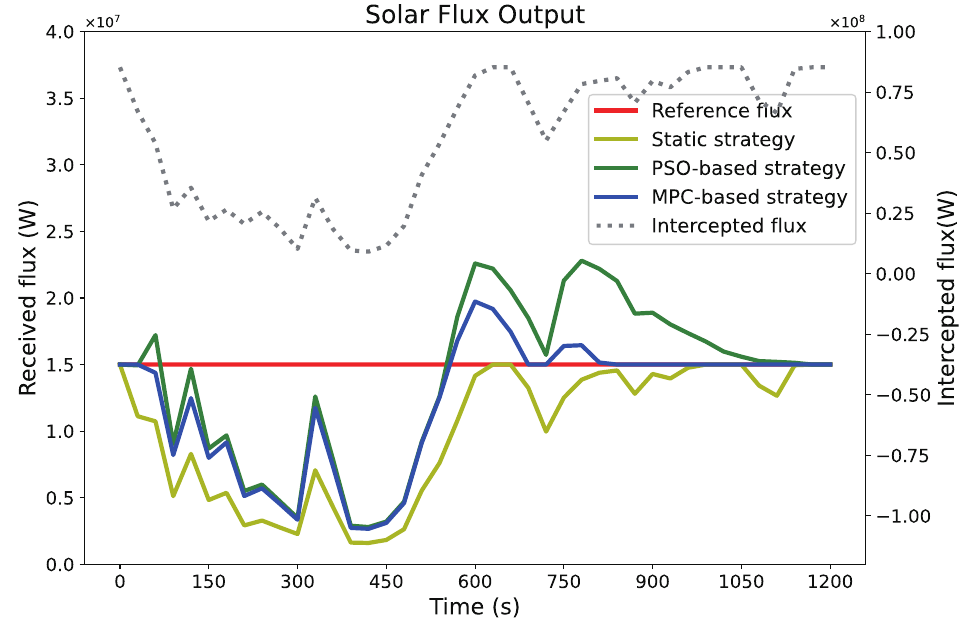
Figure 8. The comparison of the total received solar flux trajectory in the example scenario of the three